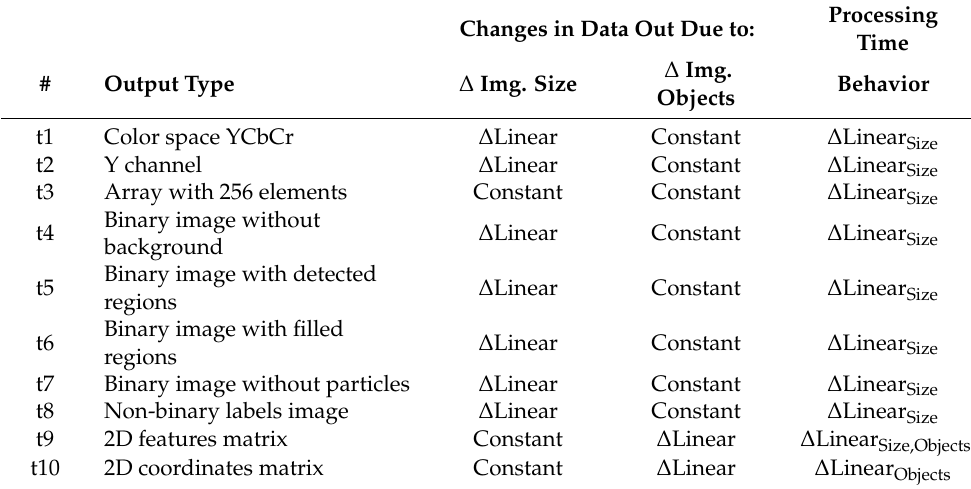
Table 1. Processing tasks, data out and processing time behaviors due to changes in image.